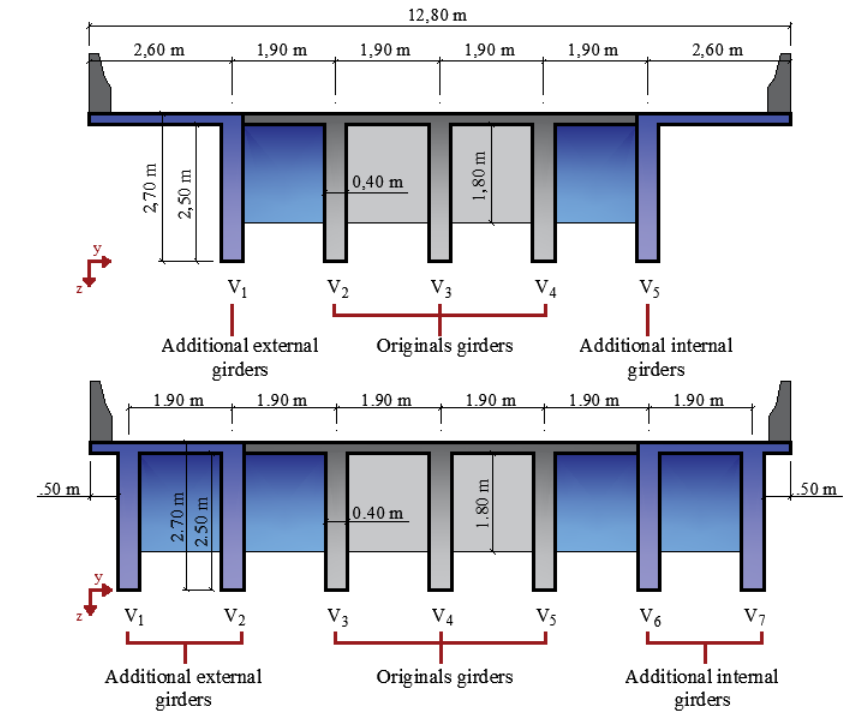
Figure 4. Cross sections after widening: (a) 5-girder model; (b) 7-girder